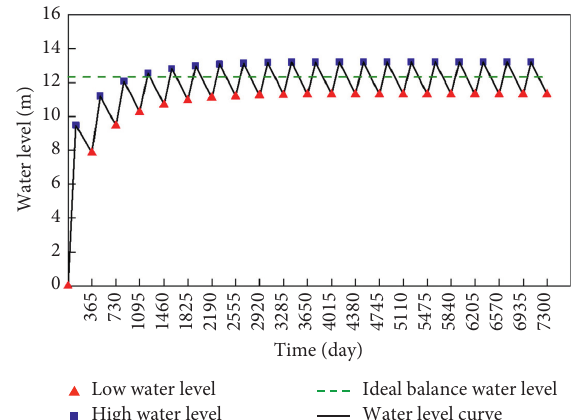
Figure 10: Water level fluctuation when one continuous rainfalls enters the reservoir under the intermediate conditions each year.